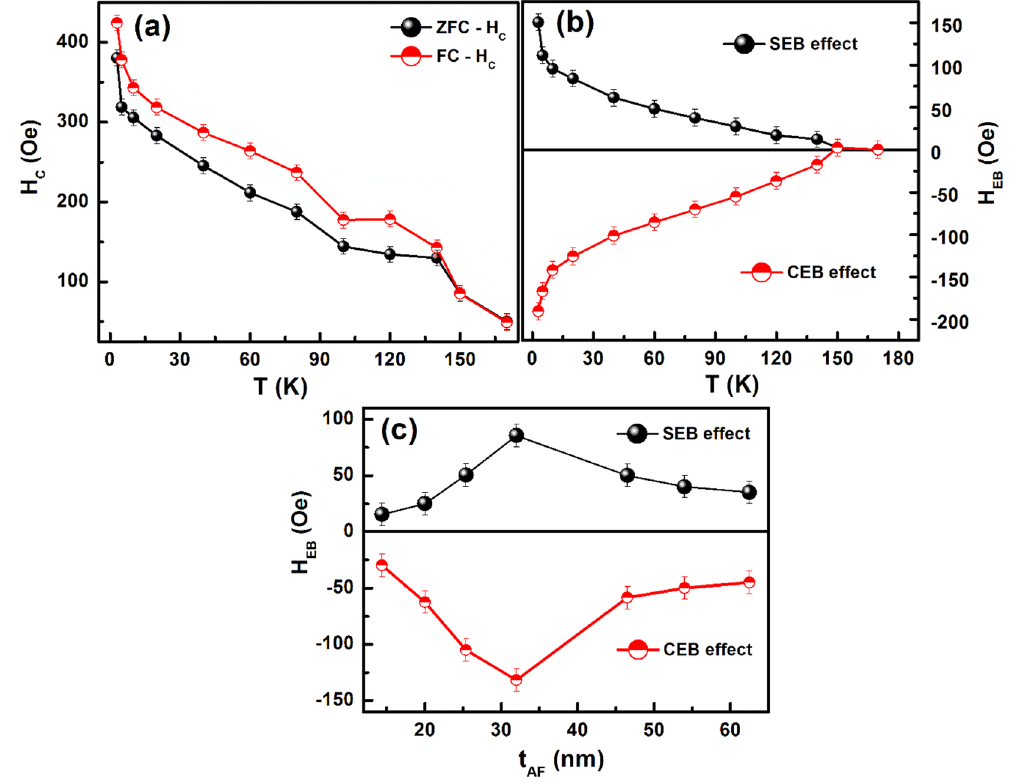
Figure 5. (a , b) Represents the temperature dependence of H C and H EB both in ZFC and FC modes, respectively. And (c) is the H SEB and H CEB as a function of AF layer thickness (t AF ) at 10 K. Lines are to guide the